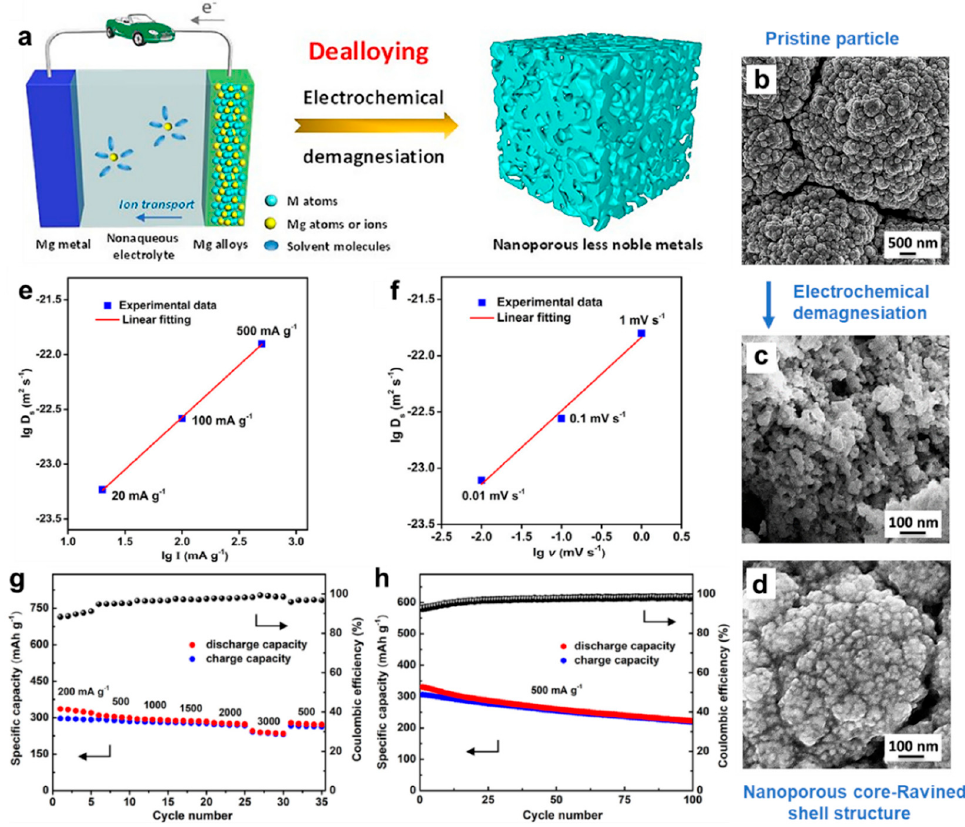
Figure 8. ( a ) Schematic illustration showing the charging-induced dealloying strategy involving electrochemical demagnesiation in MIBs. ( b – d ) SEM images of the Mg 3 Bi 2 film before and after electrochemical demagnesiation. The logarithm of surface diffusivity of Bi adatoms versus ( e ) the logarithm of current density and ( f ) the logarithm of scan rate. ( g ) Rate performance and ( h ) cycling stability of the obtained nanoporous Bi electrodes. Reproduced with permission [42]. Copyright 2021, Elsevier B.V.